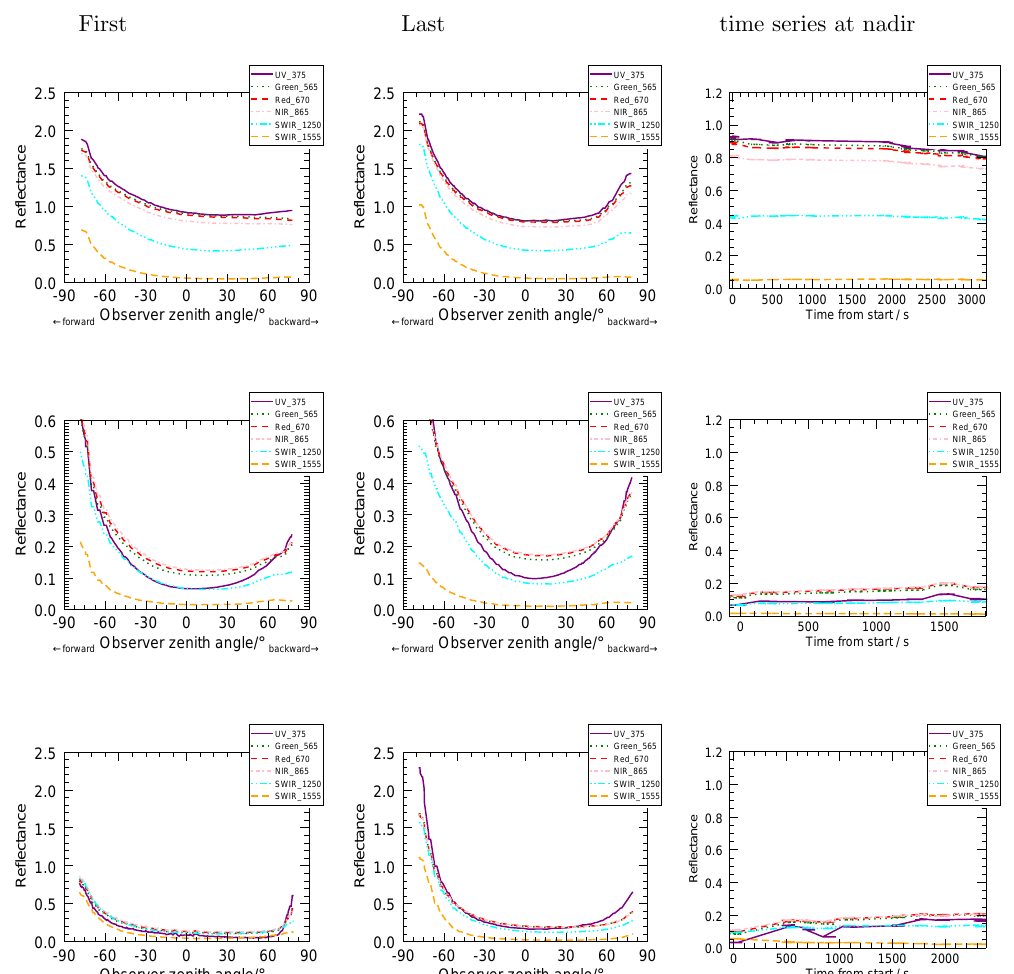
Figure 12. How the reflectance changes during the measurements. Left plots show the reflectance in the principal plane measured in the beginning of a sequence, and the plots in the middle show the same, but measured at the end of the sequence. On the right the reflectance in nadir is shown, taken at different time steps. The top shows untouched snow, the middle shows snow with fine silt 40g / 0 . 5m 2 , taken at 62 ◦ , and the bottom plots show snow samples taken at 74 ◦ . Untouched snow darkens slightly at nadir and brightens at large zenith angles, while contaminated snow brightens clearly in all directions, especially at large zenith